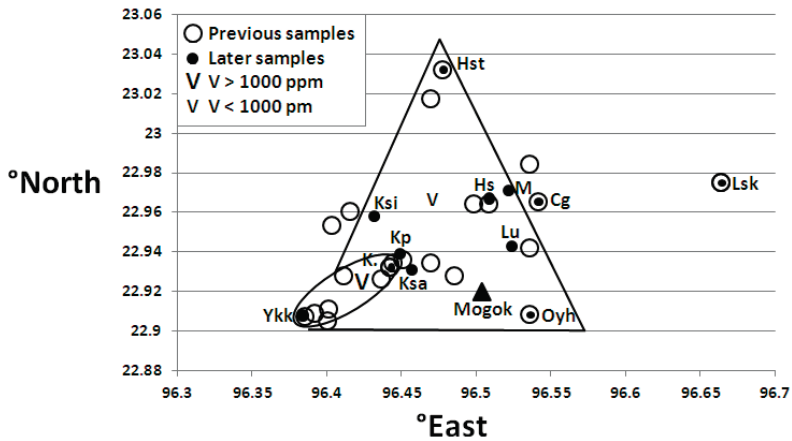
Figure 2. Locations of corundum samples analysed from the Mogok region. Samples Enclosed within the triangular zone (v) have V < 1000 ppm and in the oval area (V) have V > 1000 ppm. Localities analysed in this study (solid dots) have abbreviated symbols adapted from Table 1. Other localities (open circles) relate to the earlier study [6].